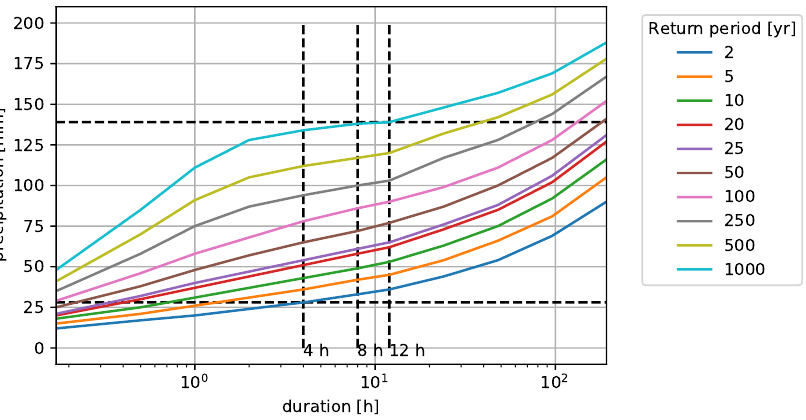
Figure 4. Precipitation intensity curves, the dashed black lines indicate maximum and minimum for the 4, 8, and 12 h